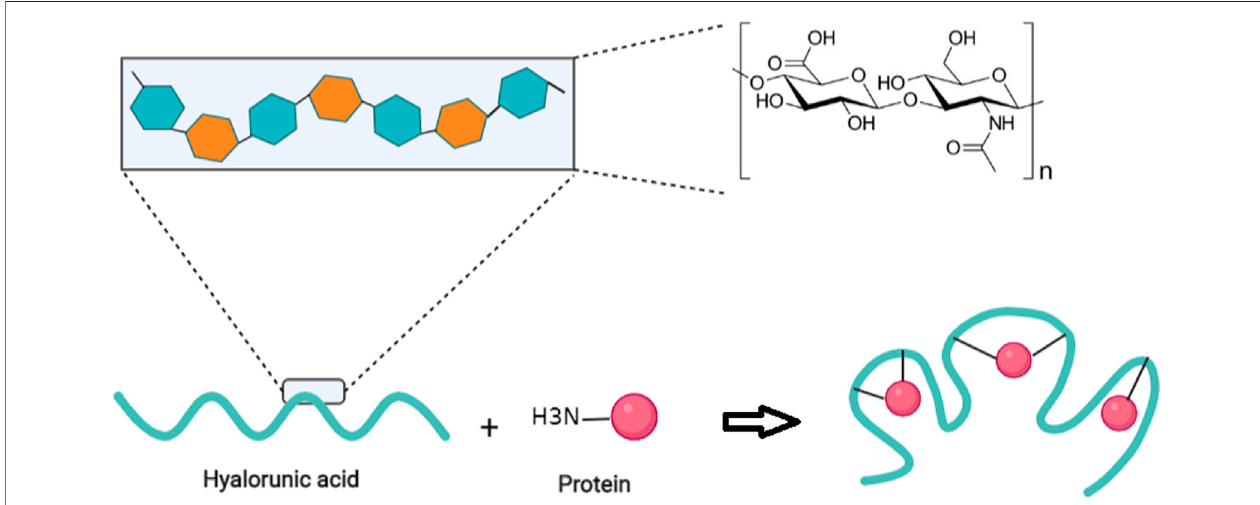
FIGURE 3 | A schematic illustration of the random conjugation of free amino groups of proteins to carboxylic groups of HA polymer. Adapted from refs (Mero and Campisi, 2014) (61) (Ghosh et al., 2017) (59) (Jing and DeAngelis, 2000) (57) (Prasad et al., 2012) (56) (Chien and Lee, 2007) (54) (Mao and Chen, 2007) (52) (Mao et al., 2009) (51) (Mao et al., 2009) (44) (Shiedlin et al., 2004) (45) (Pérez et al.,